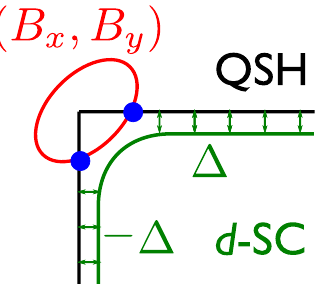
Figure 1: The schematics of the proposed setup between a QSH insulator and a d - wave superconductor coupled via superconducting proximity effect. The corner of the sample is subject to a Zeeman field and hosts two MZMs. The thick green curve denotes the boundary of a d -wave superconductor, and the interior of the red curve denotes the Zeeman field